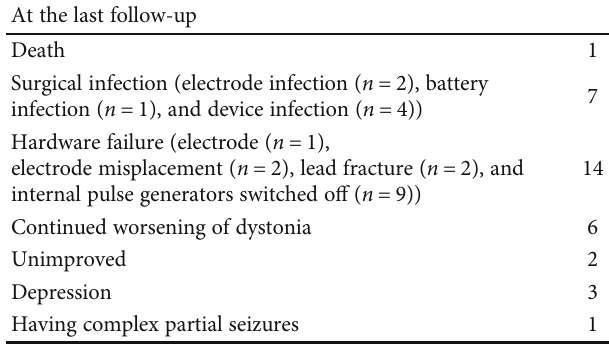
Table 5: Frequency of complications following DBS for early-onset dystonia.